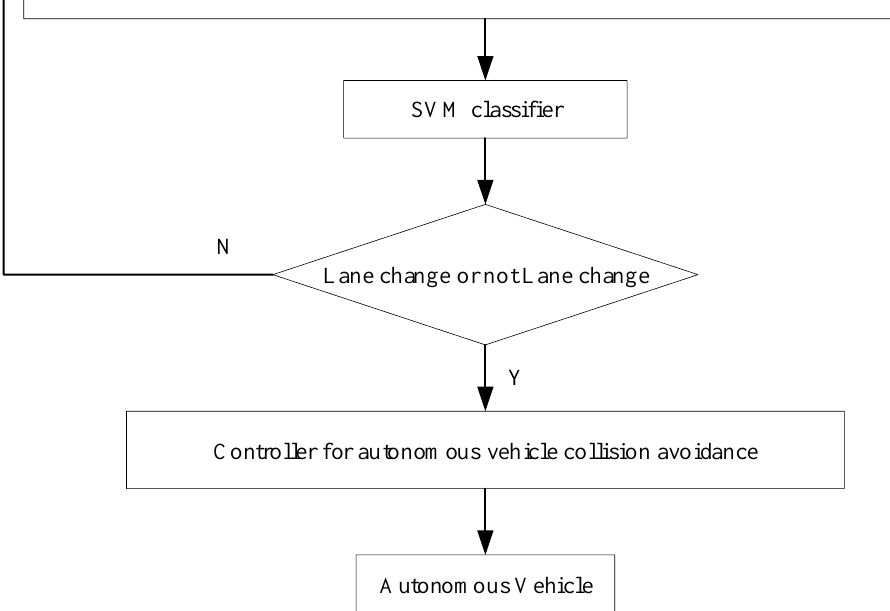
Figure 3. The overall diagram of lane change intention prediction and safety controller design.